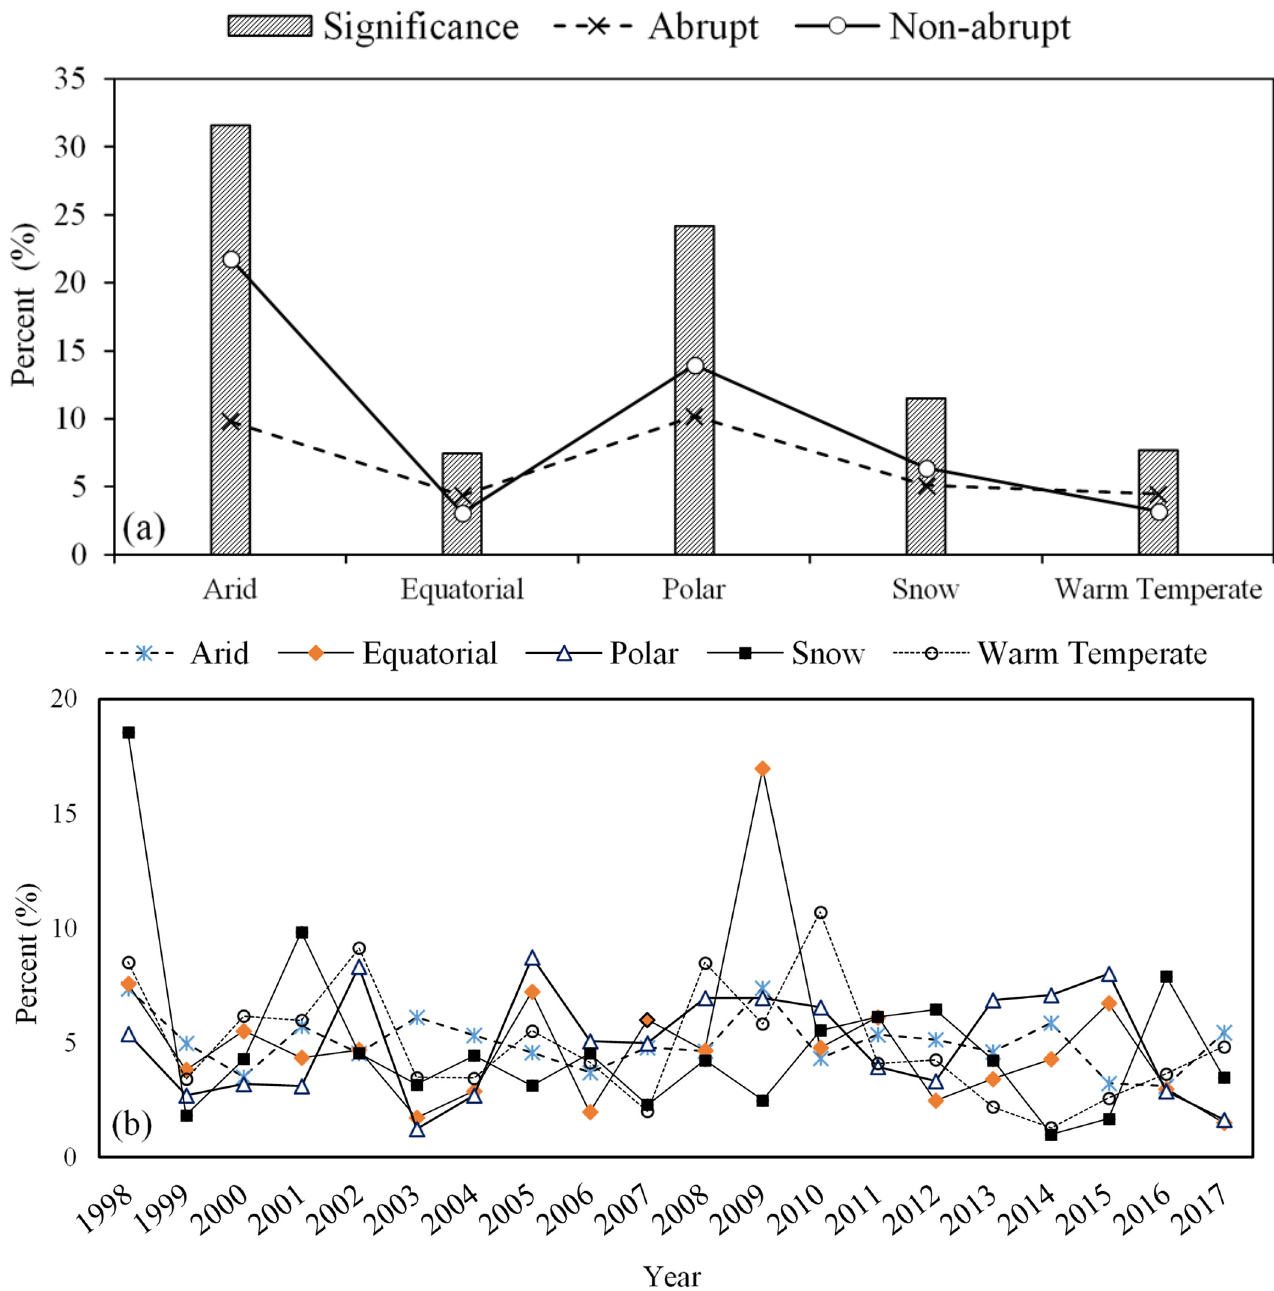
Figure 9. ( a ) Distribution of all significant breakpoints (column) and abrupt and non-abrupt changes (lines) in different climate zones and ( b ) distribution of all significant breakpoints over the 1988– 2019 period.